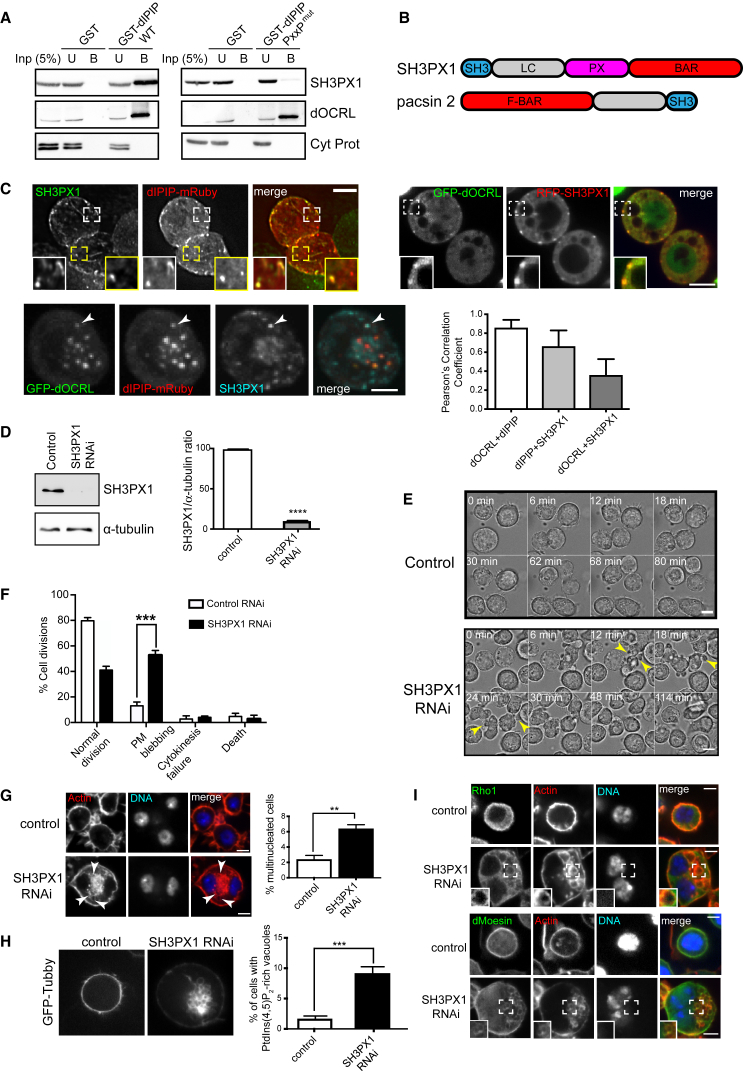
Depletion of SH3PX1 or Pacsin 2 Phenocopies IPIP Depletion in Drosophila or Human Cells, Respectively(A) Pull-down assay using GST-dIPIP or GST-dIPIP PxxP mutant (156RR157 > AA) and Drosophila S2 cell lysate, followed by western blotting of input (5%), unbound (5%), and bound fractions (50%).(B) Schematic of SH3PX1 and pacsin 2.(C) Top left: S2 cells expressing dIPIP-mRuby were fixed and labeled for SH3PX1. Top right: live still of S2 cells expressing GFP-dOCRL and RFP-SH3PX1. Bottom left: S2 cells transiently expressing GFP-dOCRL and dIPIP-mRuby and fixed and labeled for SH3PX1. Arrowheads indicate colocalization in puncta. Bottom right: colocalization analysis using Pearson’s correlation coefficient. Bars represent means ± SEM from 3 experiments with ∼30 cells per experiment Scale bar, 5 μm.(D) Western blot showing SH3PX1 depletion. The bar graph shows relative protein abundance. Values are means ± SEM of 3 independent experiments each done in triplicate. ∗∗∗∗p < 0.0001, Student’s t test.(E) Phase contrast time-lapse stills of control or SH3PX1-depleted cells undergoing cell division. Time is in minutes from metaphase. Scale bar, 5 μm.(F) Quantification of phenotypes. Bars represent the mean of 3 experiments with ∼60 cells analyzed per condition per experiment. Error bars represent SEM. ∗∗∗p < 0.0001, chi-square analysis.(G) Left: RNAi-treated S2 cells were stained with phalloidin (red, F-actin) and Hoechst 33342 (blue, DNA). Arrowheads indicate actin-positive vacuoles. Right: quantitation of multinucleation. Bars represent the mean ± SEM of 3 experiments with ∼500 cells per experiment. ∗∗∗p < 0.0001, Student’s t test.(H) Left: live stills of control or SH3PX1-depleted S2 cells stably expressing GFP-Tubby. Right: quantitation of PtdIns(4,5)2-rich vacuoles. Bars represent the mean ± SEM of 3 experiments with ∼300 cells per condition per experiment. ∗∗∗p < 0.0001, Student’s t test.(I) RNAi-treated S2 cells labeled with anti-Rho1 anti-dMoesin (green), phalloidin (red), and Hoechst 33342 (blue). Scale bars, 5 μm.See also Figures S4–S6 and Video S6.